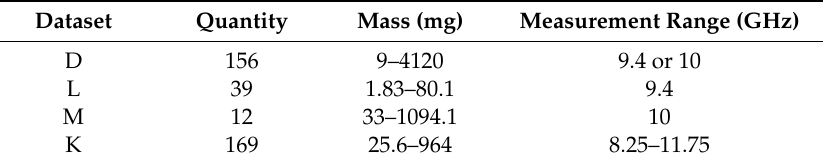
Table 2. Experimental datasets included in this research 1